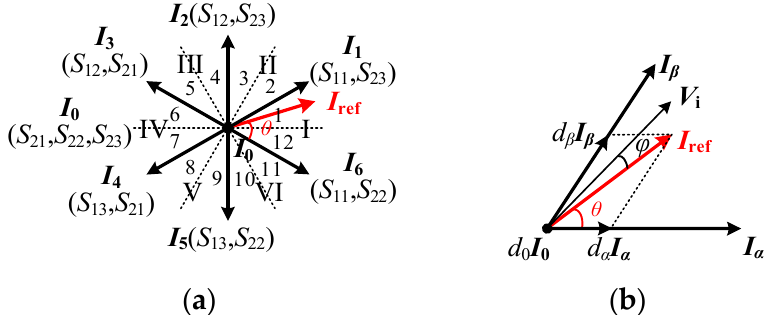
Figure 3. Space vector pulse width modulation (SVPWM) schematic diagram. ( a ) Input current vectors and sector partitions. ( b ) Synthesis of the reference current vector.